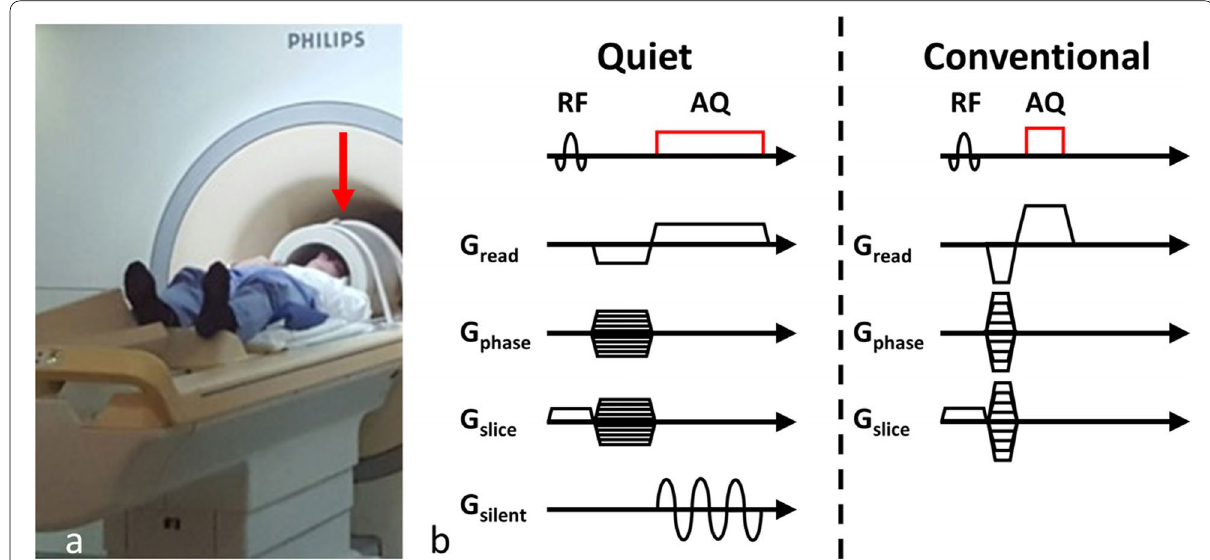
Fig. 1 a The silent gradient coil used in this work (indicated by the red arrow). b Sequence diagrams of the readout of the quiet and conventional